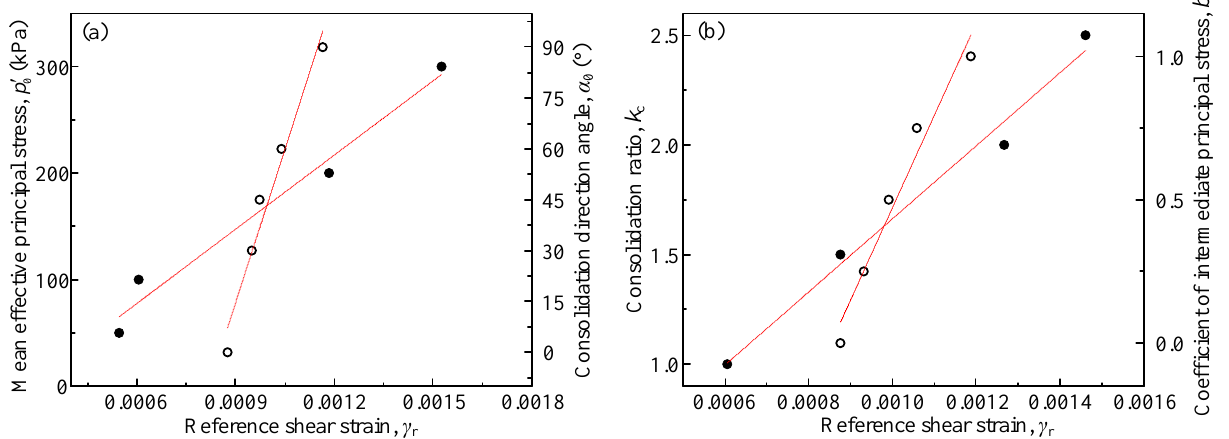
Figure 13. The correlation between γ r and stress characteristic parameters of ( a ) effective mean principal stress and consolidation direction angle, ( b ) consolidation ratio and coefficient of intermediate principal stress.